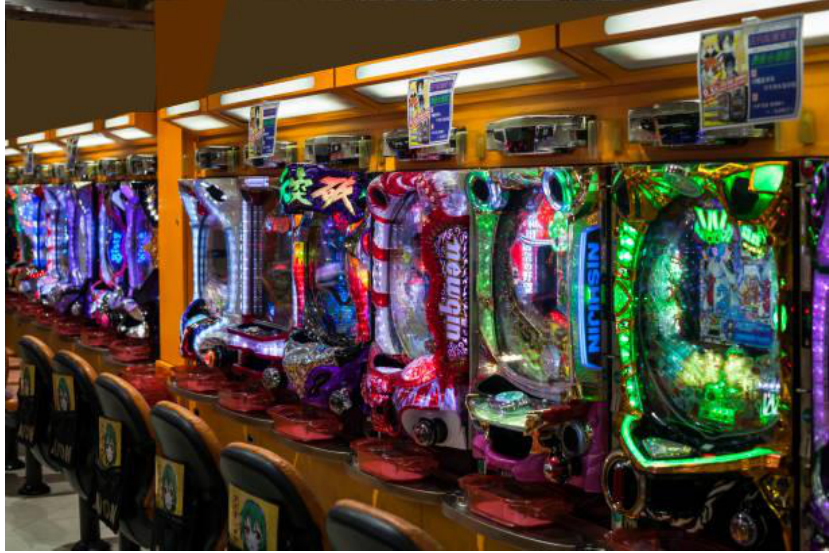
Figure 3. Pachinko parlor.